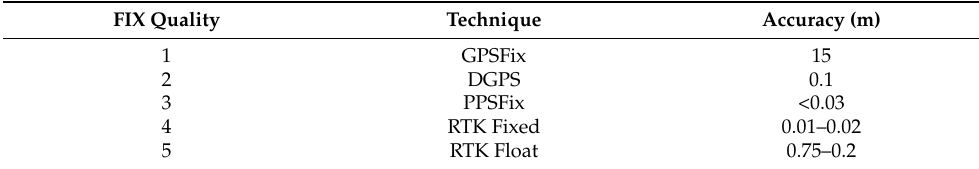
Table 7. GPS FIX status enumeration and technique accuracy [34,38,39].